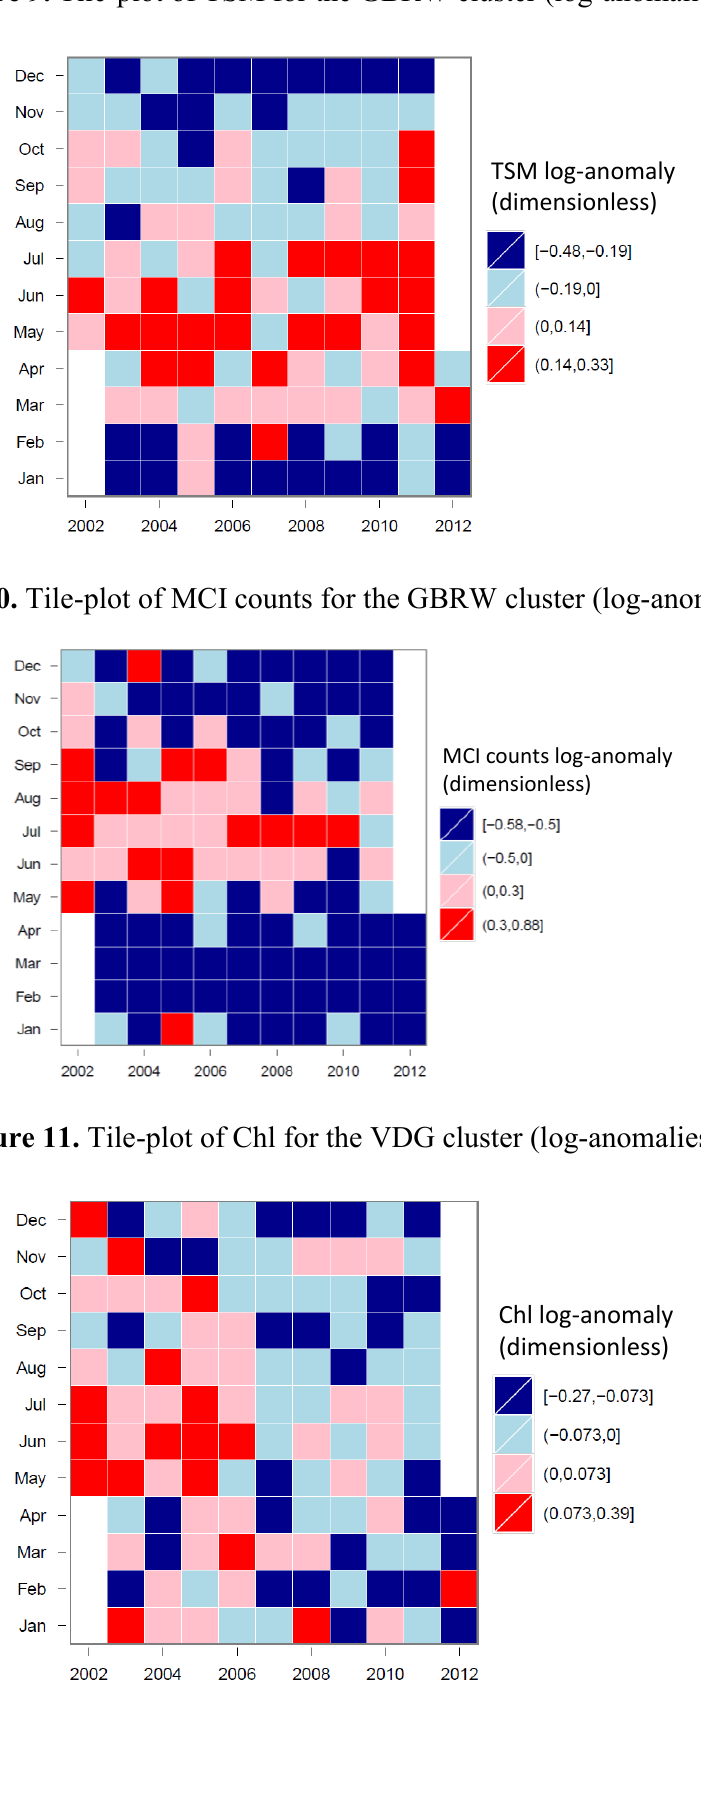
Figure 9. Tile-plot of TSM for the GBRW cluster (log-anomalies).